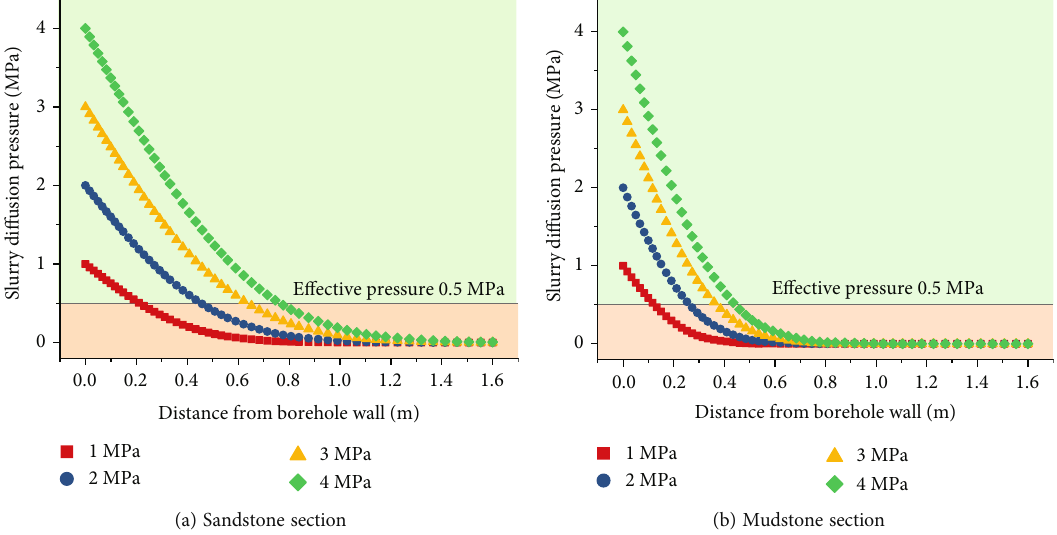
Figure 11: E ff ective seepage radius of the slurry in di ff erent rock sections.